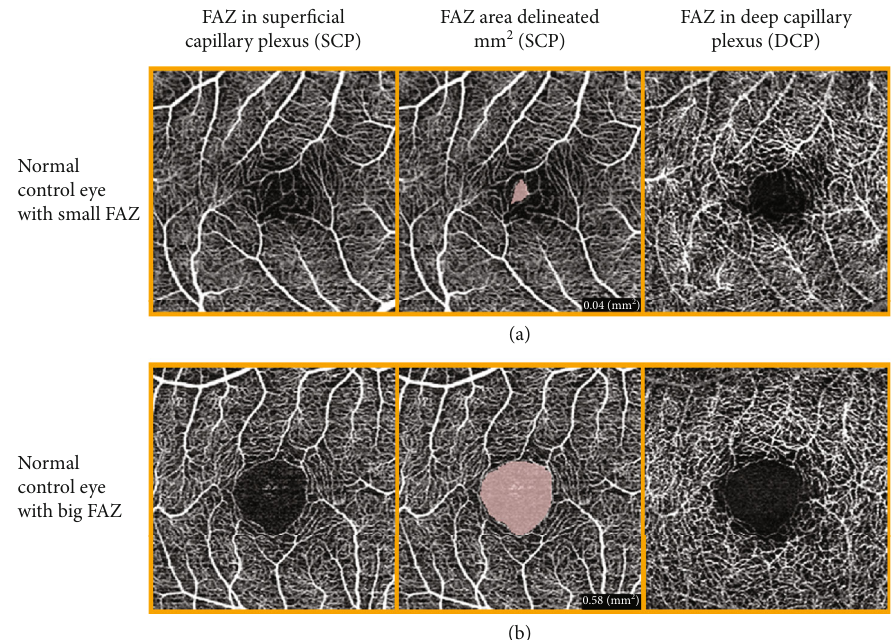
Figure 1: OCTA scans from two control eyes. This illustrates how the FAZ area is delineated and how di ff erent the size and shape can be in normal eyes. (a) The FAZ is 0.04mm 2 in the SCP, and crossing capillaries in the FAZ area makes it di ffi cult to decide where to measure. (b) The FAZ is 0.58mm 2 in the SCP.